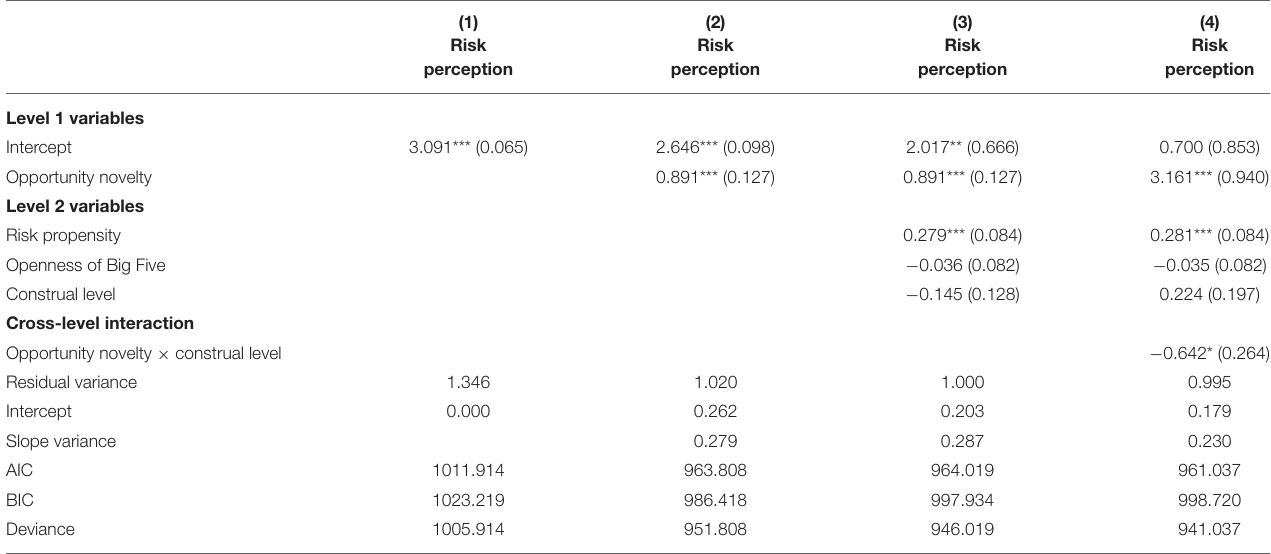
TABLE 3 | HLM results for the interactive effect of opportunity novelty and construal level on risk perception.